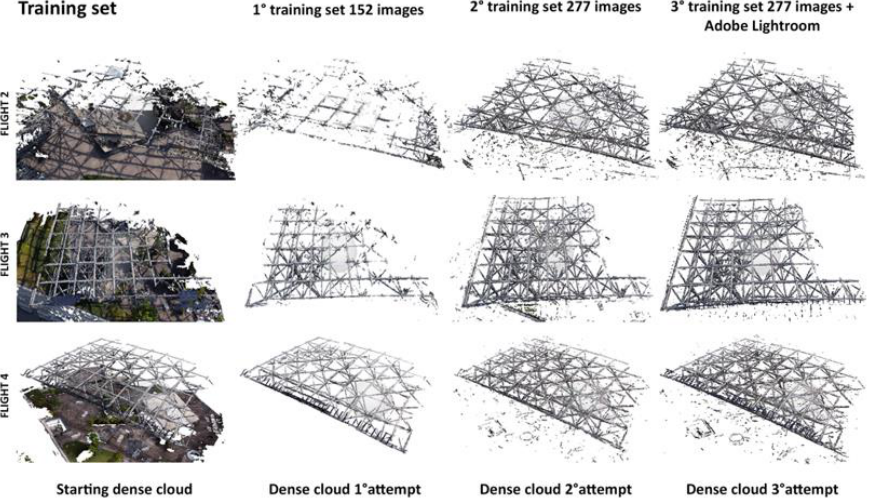
Figure 27. Masks resulting from the sum of the third attempt with those of the second attempt.